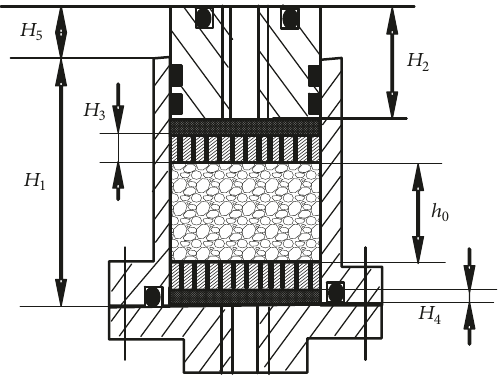
Figure 3: Sketch of calculating the height of the granular